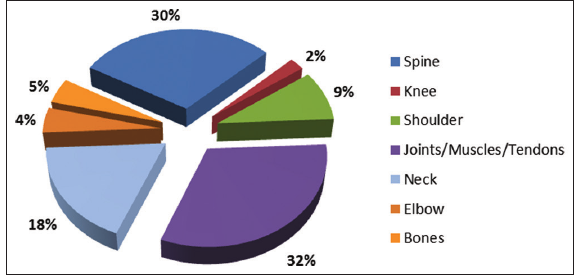
FIGURE 1. Distribution of articles per pain locations treated with CRet therapy.